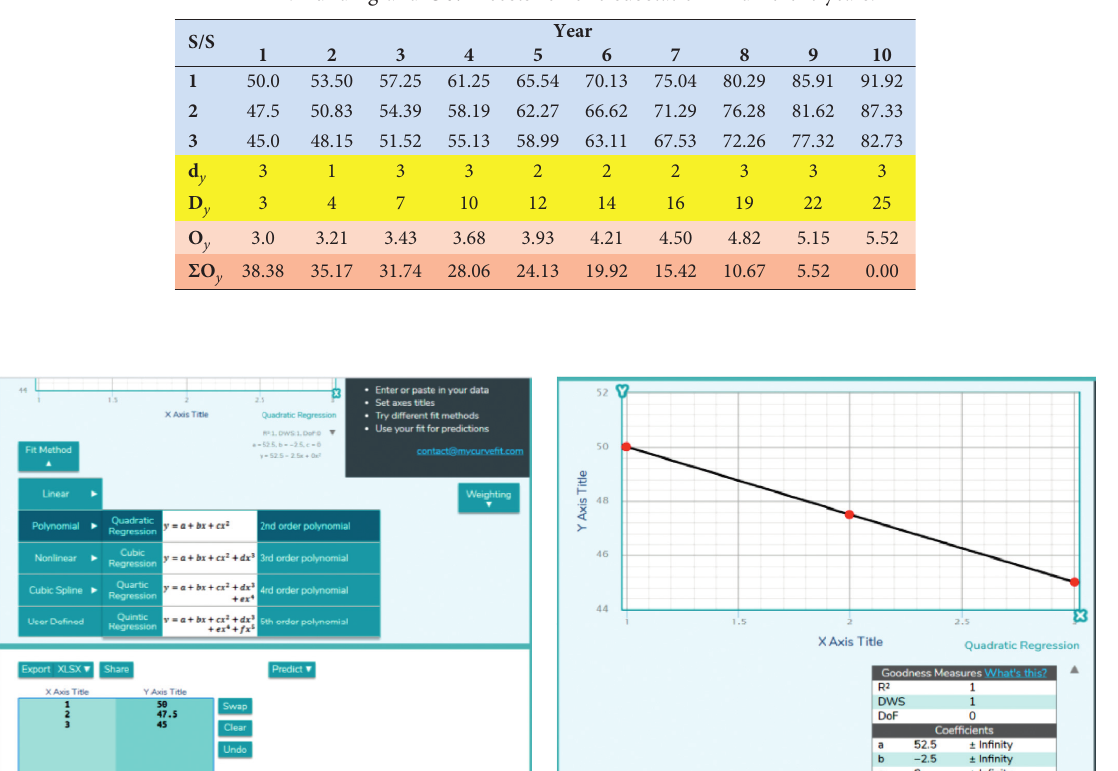
Table 2: Building and O&M costs for one substation in different years.